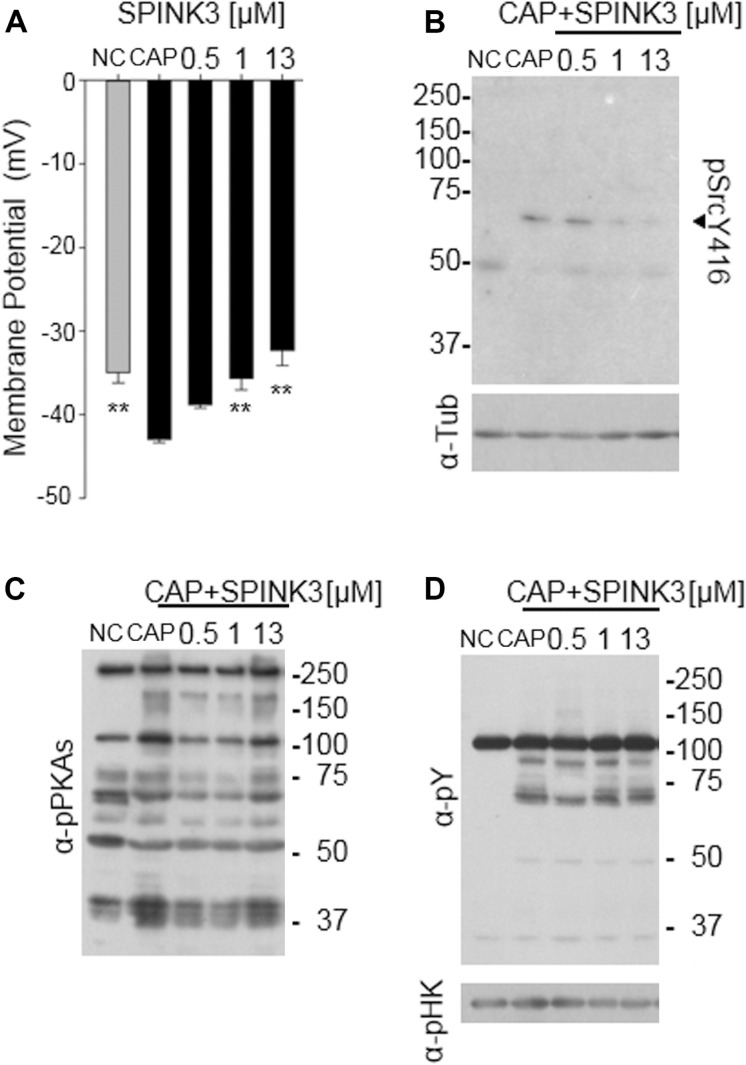
Effect of SPINK3 on sperm membrane potential (Em) and associated pathways. (A)
Em measurements of DISC3(5)-loaded sperm, incubated for 60 min in non-capacitating (NC, gray bar) or capacitating (CAP, black bars) conditions containing the specified SPINK3 concentrations. Data represent mean ± S.E., n = 4, ** values significantly different (p < 0.01) compared to CAP; (B,C) after sperm incubations as detailed in (A), western blot analyses were performed with anti pSrcY416 antibodies (B) (clone D49G4), further stripped and re-probed with anti-tubulin (α-Tub) antibodies. Alternatively, western blot analyses were performed with anti-pPKAs (clone 100G7E) (C), further stripped and re-probed with anti-pTyr (α-pY) (clone 4G10) (D). Western blot analyses are representative of experiments repeated at least three times. p-hexokinase (116 kDa, α-pHK) detected with anti-pY, is showed as loading control.